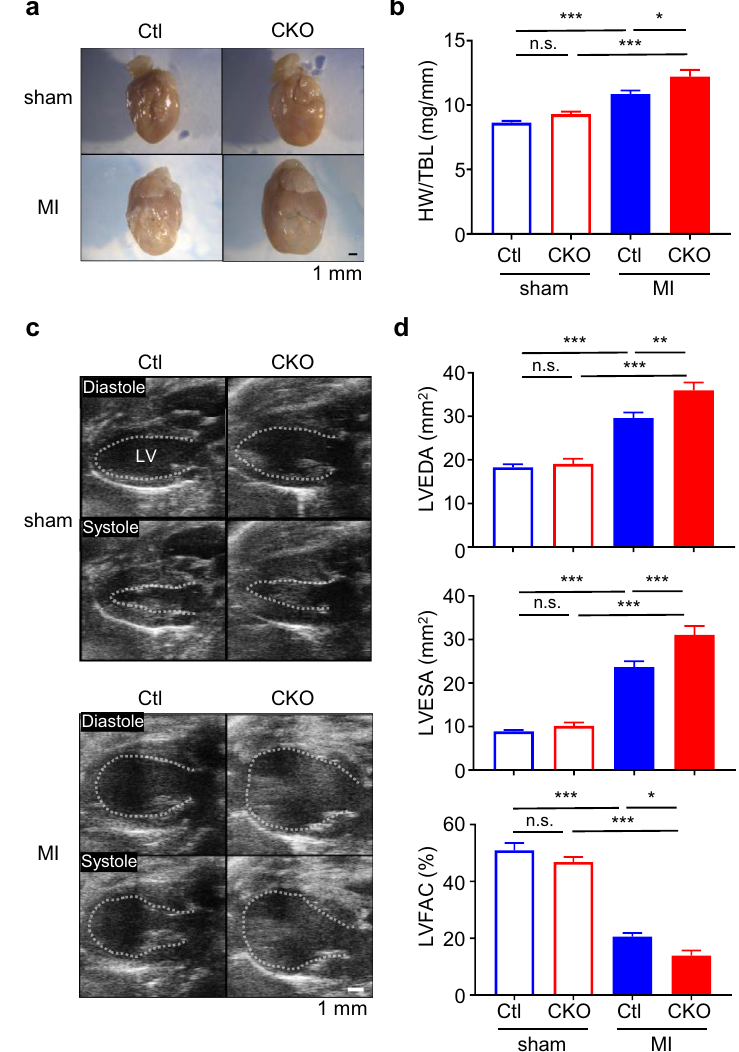
Figure 2. Deletion of Cxcr7 in cardiomyocytes exacerbates post-infarction remodeling. ( a ) Representative images of infarcted hearts from Ctl and CKO mice 4 weeks after ligation of a left anterior descending artery to induce myocardial infarction. ( b ) Heart weight-to-tibia length ratio (HW/TBL) of infarcted mice. sham-Ctl, n = 10; sham-CKO, n = 9; MI-Ctl, n = 15; MI-CKO, n = 9. Data are shown as the mean ± SEM. Significance was calculated by one-way ANOVA followed by the Bonferroni procedure. * P < 0.05, *** P < 0.001. ( c ) Representative B-mode images of transthoracic echocardiography at diastole and systole of sham and infarcted hearts in Ctl and CKO mice. The dashed line indicates the endocardial surface of the left ventricular (LV) cavity. ( d) Left ventricular end-diastolic area (LVEDA), end-systolic area (LVESA), and fractional area change (LVFAC) assessed by echocardiography 4 weeks after myocardial infarction. (sham-Ctl, n = 10; sham-CKO, n = 9; MI-Ctl, n = 15; MI-CKO, n = 9). Data are the mean ± SEM. Significance was calculated by one-way ANOVA followed by the Bonferroni procedure. * P < 0.05, ** P < 0.01, *** P <